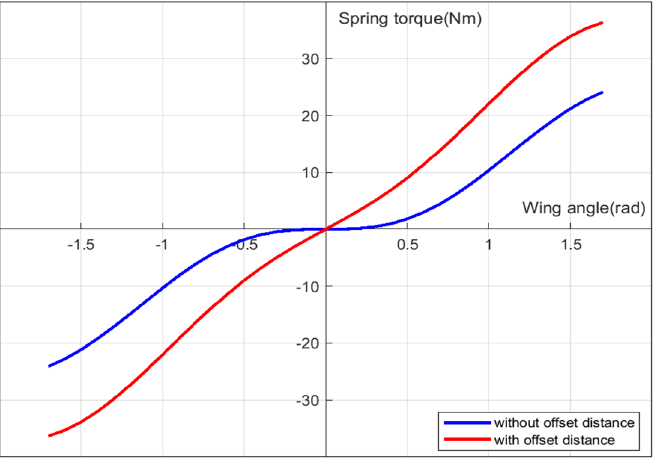
Figure 5. Spring torque with wing rotation angle.